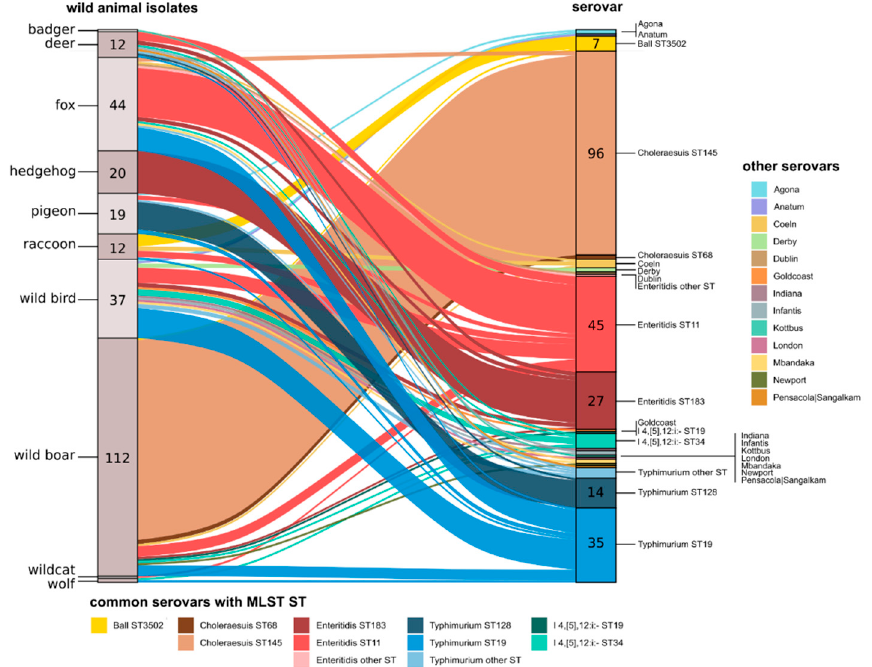
Figure 2. Relationships between the wildlife host species and serovar/MLST sequence types of the Salmonella enterica isolates.The alluvial plot visualizes the relationships between host species and serovar/MLST sequence types of the wildlife Salmonella enterica isolates. The left y-axis represents the wildlife host species with the number of isolates obtained from each species indicated. The right y-axis represents the serovar (major serovars are further split by ST) with the number of isolates for each serovar/ST indicated. The alluvia are coloured by serovar/ST.